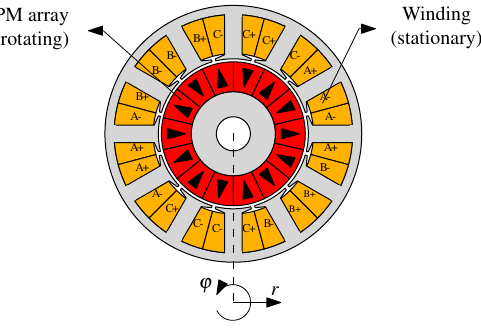
Figure 3. Fractional-slot concentrated-windings PM motor.